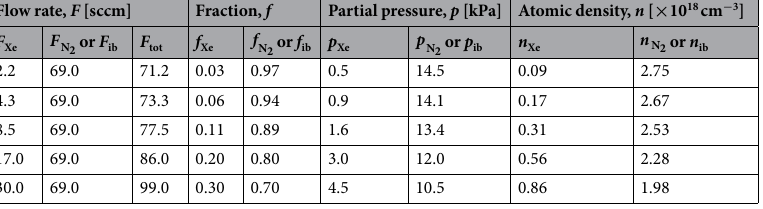
Table 1. Flow rates and volume fractions of the gas mixture, and partial pressures and number densities of atoms in SEOP cell at a temperature of 383 K and total pressure of 15 kPa. The temperature inside the cell was assumed to be the same as the one of the